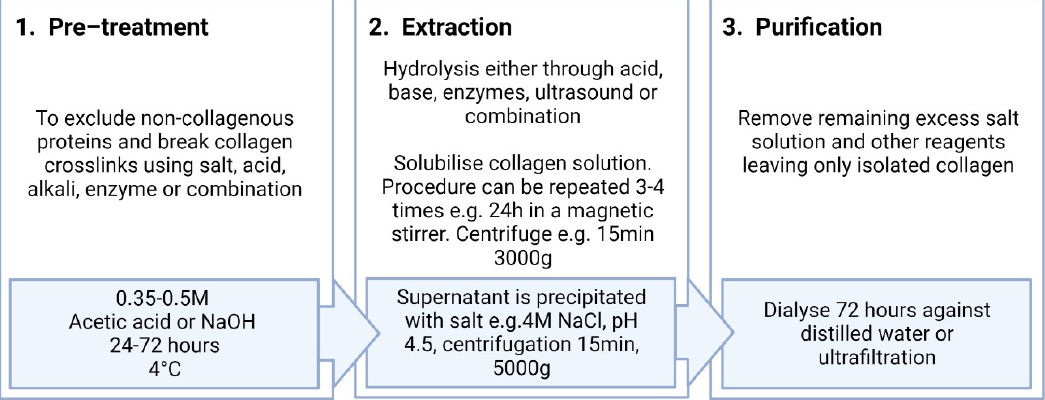
Figure 3. Steps of the collagen isolation process: an overview. Examples of methods from Mogan et al. [73]. Different tissues require different optimisation in the reagent’s concentration, pH, processing time, and temperature.